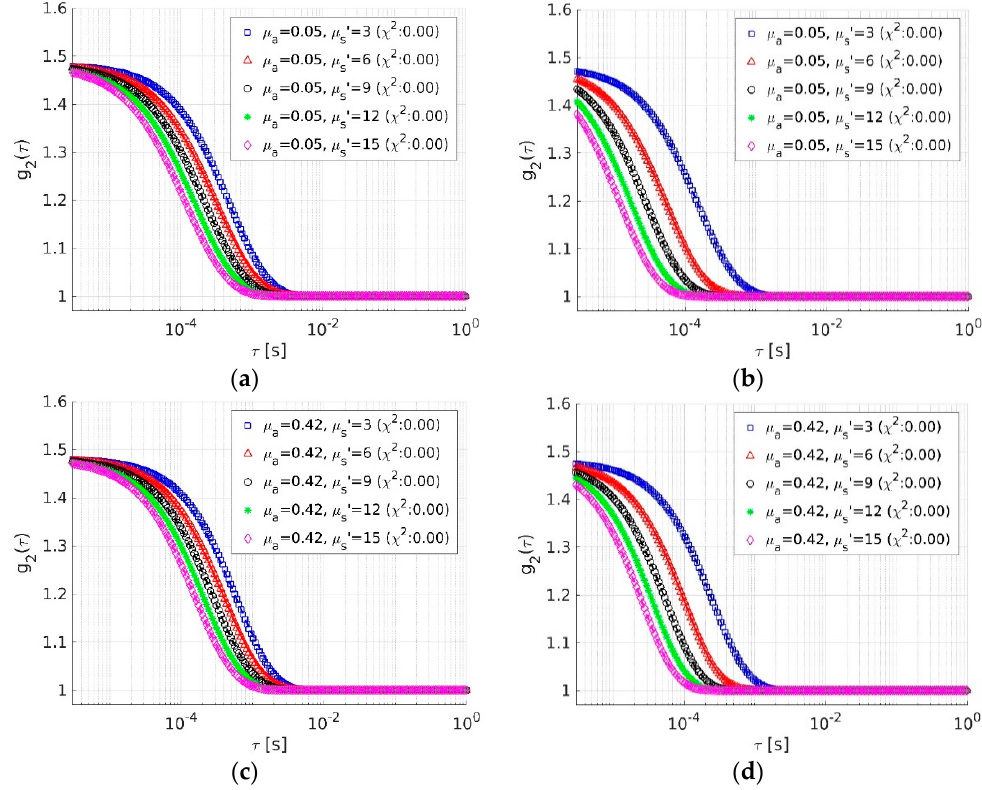
Figure 3. MC simulations (symbols) with fitted curves using Equation (2) (lines) via optimizing for the Brownian flow coe ffi cient D B (inverse model) to minimize χ 2 residuals. Simulated data shown in ( a , d